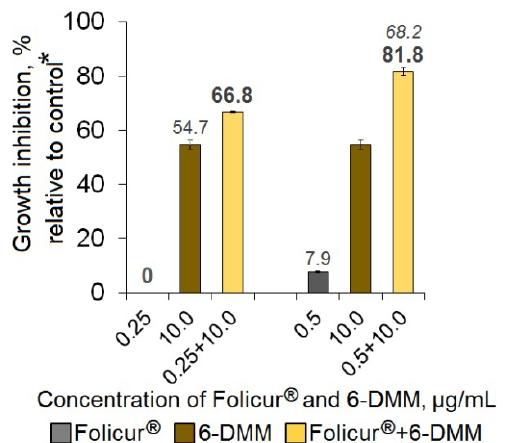
Figure 5. Synergistic augmentation of the in vitro suppression of the Bipolaris sorokiniana growth by ineffective Folicur ® doses after their combining with 6-DMM (10.0 µg/mL). Each bar represents the mean of three experiments. The italic number above the column indicates E e , other numbers indicate E r values; E r > E e at p < 0.05 (see Materials and Methods, Section 4.4). * Control colonies were cultured on potato dextrose agar free of 6-DMM and the fungicide.